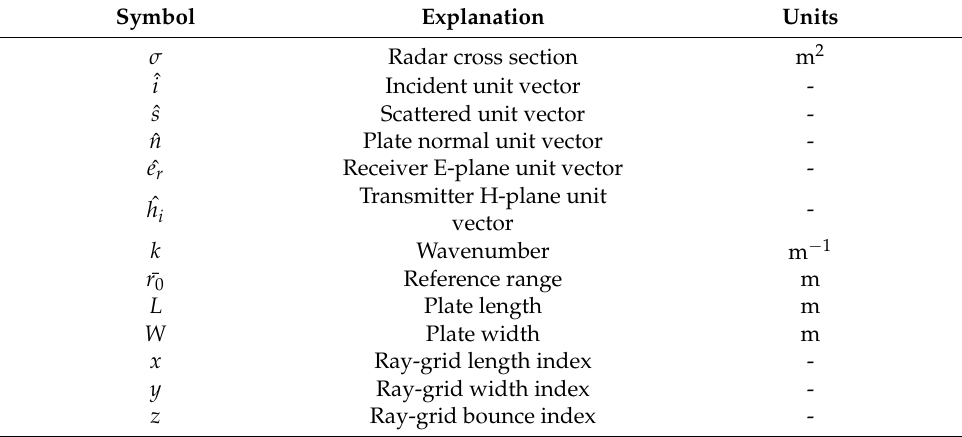
Table 1. Summary of nomenclature